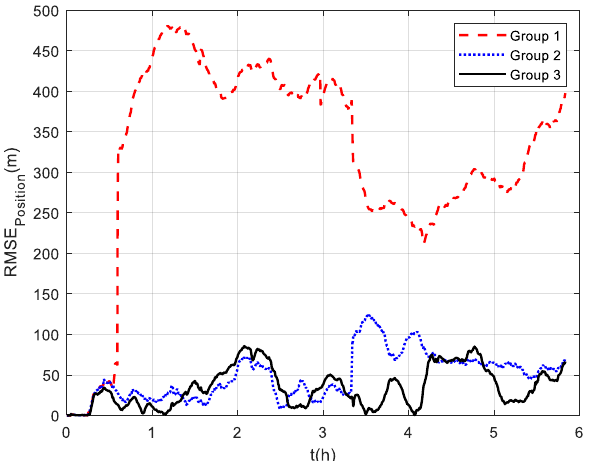
Figure 10. RSME of positions at mid − latitudes.